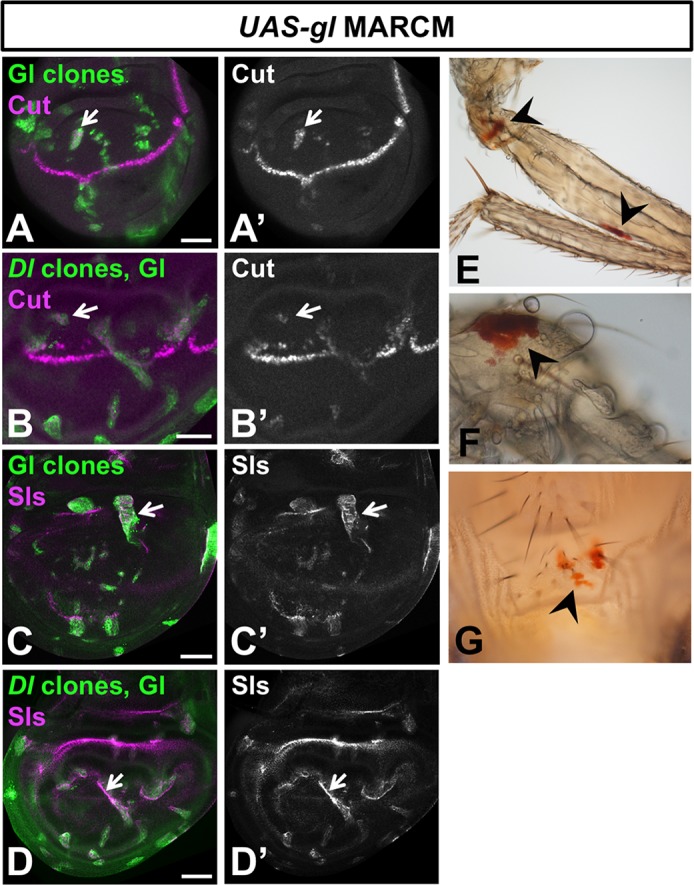
Gl induces cone and pigment cell markers.(A-D) wing discs in which UAS-gl is expressed in wild type (A, C) or DlRevF10 (B, D) clones induced by Ubx-FLP, marked with GFP (green) and stained with anti-Cut (A’, B’, magenta in A, B) or anti-Sls (C’, D’, magenta in C, D). The cone cell markers Cut and Sls are induced in Gl-expressing clones (arrows) even if these are unable to activate the Notch pathway in neighboring cells. Adult legs (E, F) and abdomen (G) from flies in which Gl-expressing clones were induced with ey-FLP (E, F) or Ubx-FLP (G). Ectopic red pigment resembling eye pigment can be seen on the cuticle (arrows). Scale bars: 50μm.